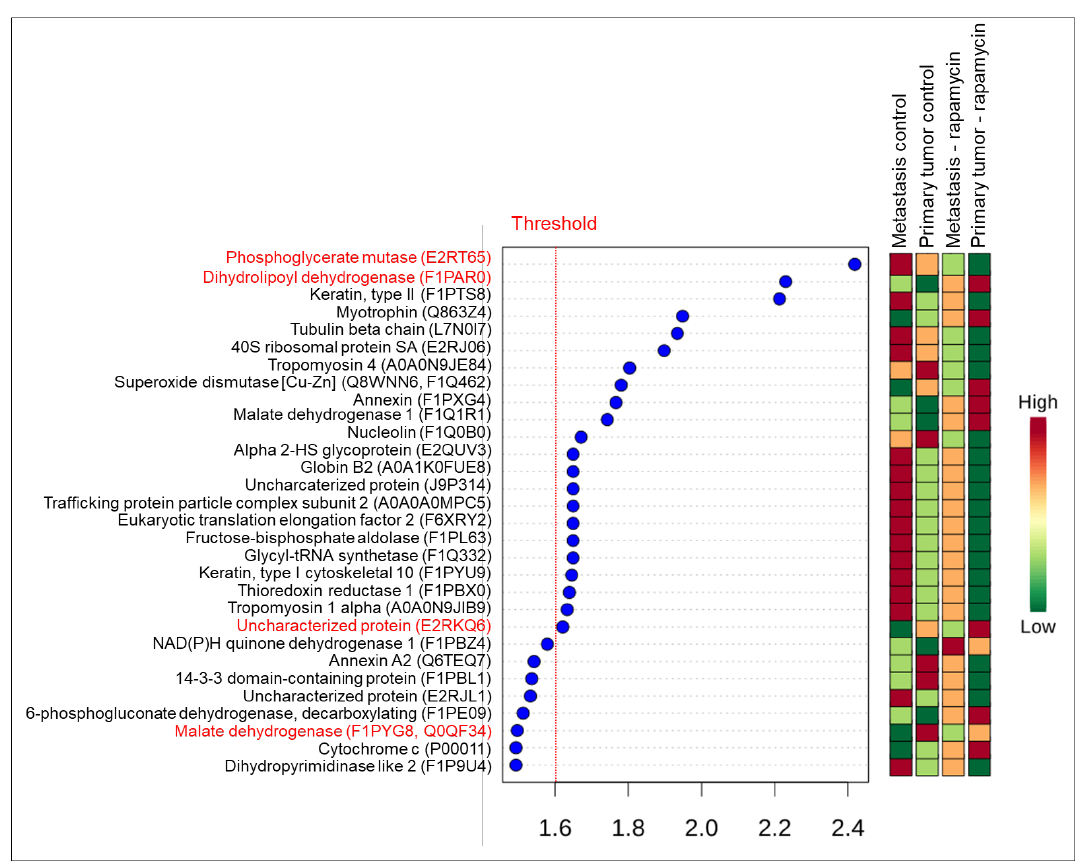
Figure 5. VIP score from PLS-DA. Colored boxes indicate the protein abundance in each group (metastasis control versus primary tumor control versus metastasis treated with rapamycin versus primary tumor treated with rapamycin). Threshold considered for VIP score was α > 1.6. Proteins in red color were also found in ANOVA one-way analysis (FRD < 0.05).